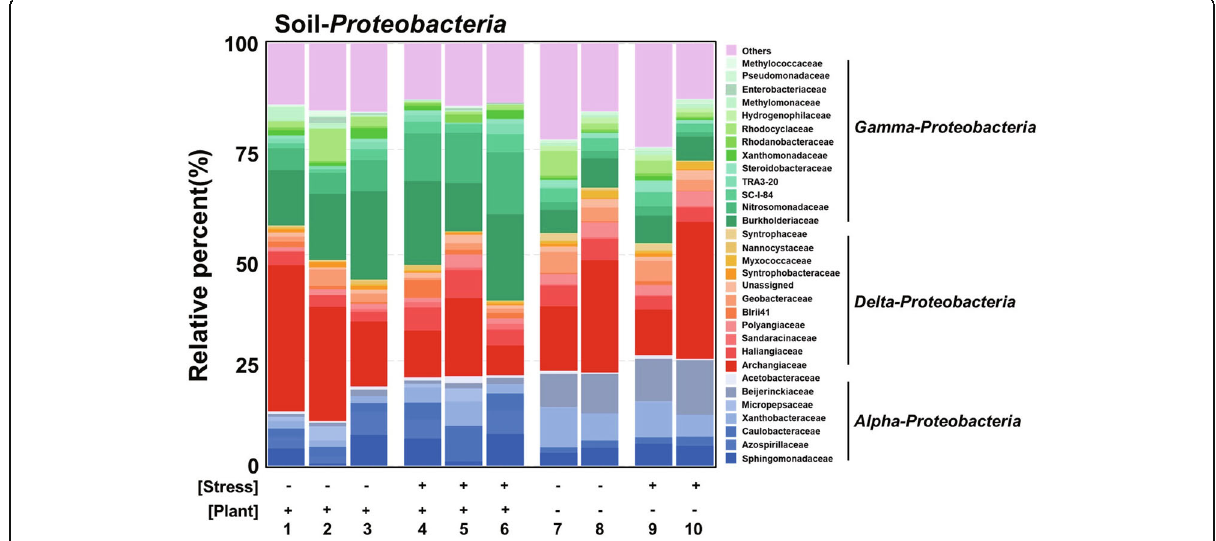
Fig. 3 Relative abundance of the 30 most abundant Proteobacteria families from soil samples differentiated according to presence of drought stress or plants. Data points represent the abundance of each family relative to the total abundance of all families in each sample. The 30 most abundant families in each treatment were integrated, resulting in the identification of 31 families (one group consists of unassigned families). Each color represents a microbe in the following classes: Alphaproteobacteria (blue); Deltaproteobacteria (red); and Gammaproteobacteria (green). Bacteria not belonging to these classes are clustered as “ Others. ” Grids are set according to the application of stress (drought (+)/watered ( − )) and presence of plant (with (+)/without ( − )). Detailed information of each sample is presented in Table